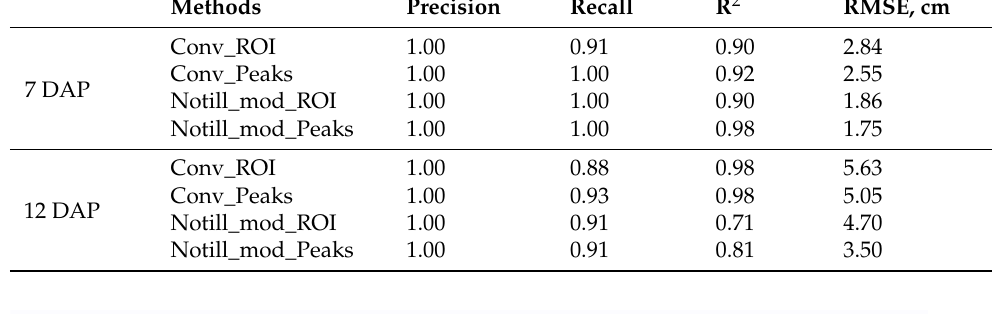
Figure 3. Illustrative example of ( a ) misdetection due to leaves overlapping and ( b ) intra-row weeds. Table 1. Detection and accuracy results from both methods.